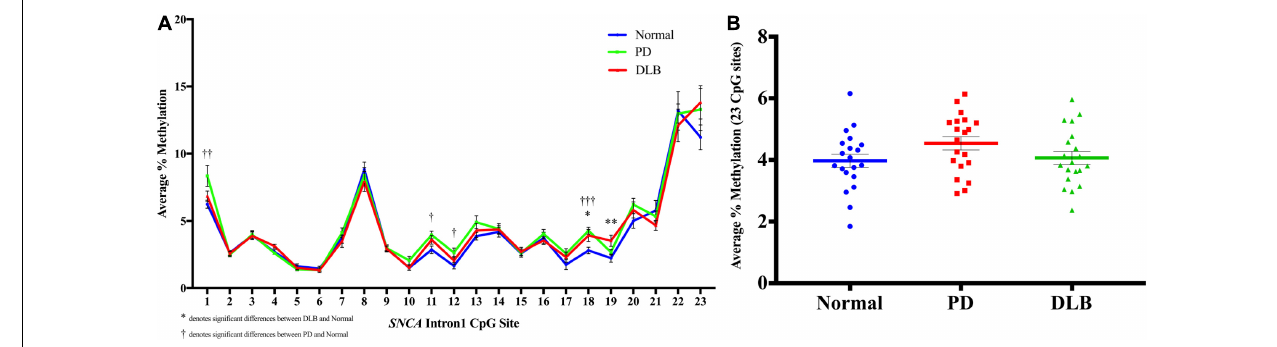
FIGURE 2 | DNA methylation profiles of the SNCA intron 1 CGI in the bulk frontal cortex tissues. DNA from each bulk frontal cortex sample was bisulfite converted, and the methylation (%) of the individual CpGs was quantitatively determined by pyrosequencing. (A) Graph depicts the average percentage of DNA methylation level for 20 PD, 20 DLB, and 20 matched normal control subjects at each of the 23 CpG sites within the SNCA intron 1 CGI. (B) Box-and-scatterplot chart displays for each subject the DNA methylation average percentages across all 23 CpG sites within the SNCA intron 1 CGI [Chr4: 89,836,150-89,836,593 (GRCh38/hg38)] (denoted by colored points). The box plot also depicts the mean (denoted by colored horizontal line) and upper and lower quartiles (denoted by gray thin lines) of DNA methylation average percentages across all 23 CpG sites for all subjects in each group of PD, DLB, and normal control. The significance of the differences in % of methylation was determined using one-way ANOVA followed by Dunnett’s post hoc test and denoted by asterisks ( ∗ ) for DLB vs normal, and by obelisks ( † ) for PD vs normal comparisons, with ∗ / † p 0.05, ∗∗ / †† p 0.01, and ∗∗∗ / ††† p 0.005.